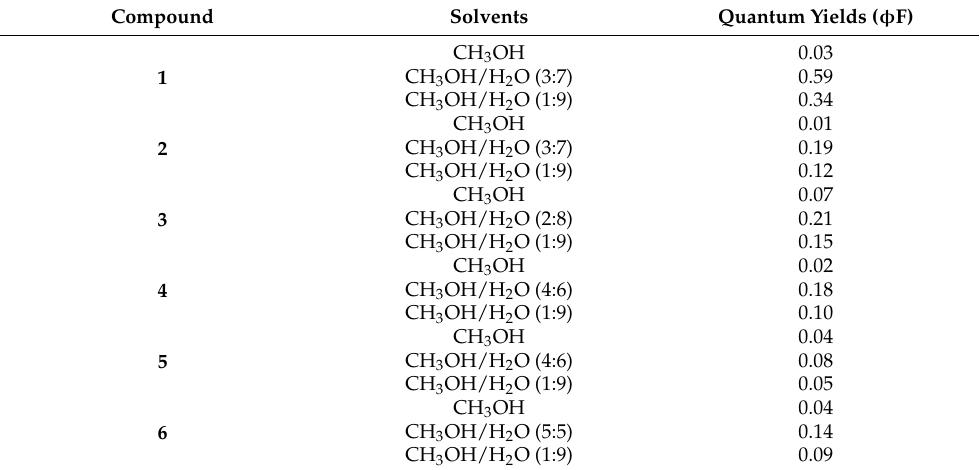
Table 2. Fluorescence quantum yield of compounds 1 – 6 in CH 3 OH/H 2 O mixed solution with various water fractions.